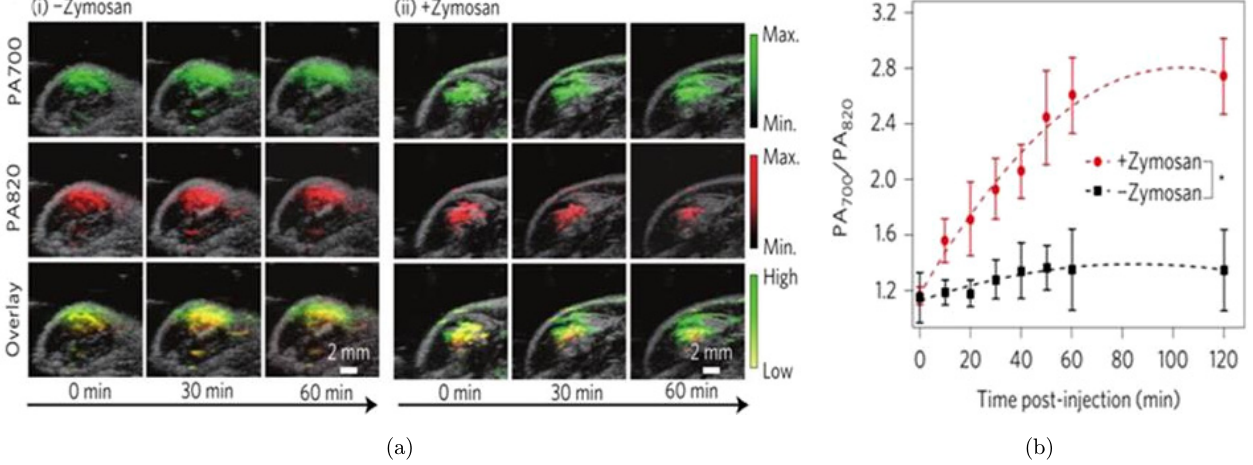
Fig. 8. In vivo PAT of ROS generation from a mouse model of acute edema using RSPN. 56 (a) PA/US overlaid images of saline- treated (i) and zymosan-treated (ii) regions in the thigh of living mice ( n ¼ 3). (b) Ratio of PA amplitude at 700 nm to that at 820 nm (PA 700 /PA 820 ) as a function of time post-injection of RSPN.